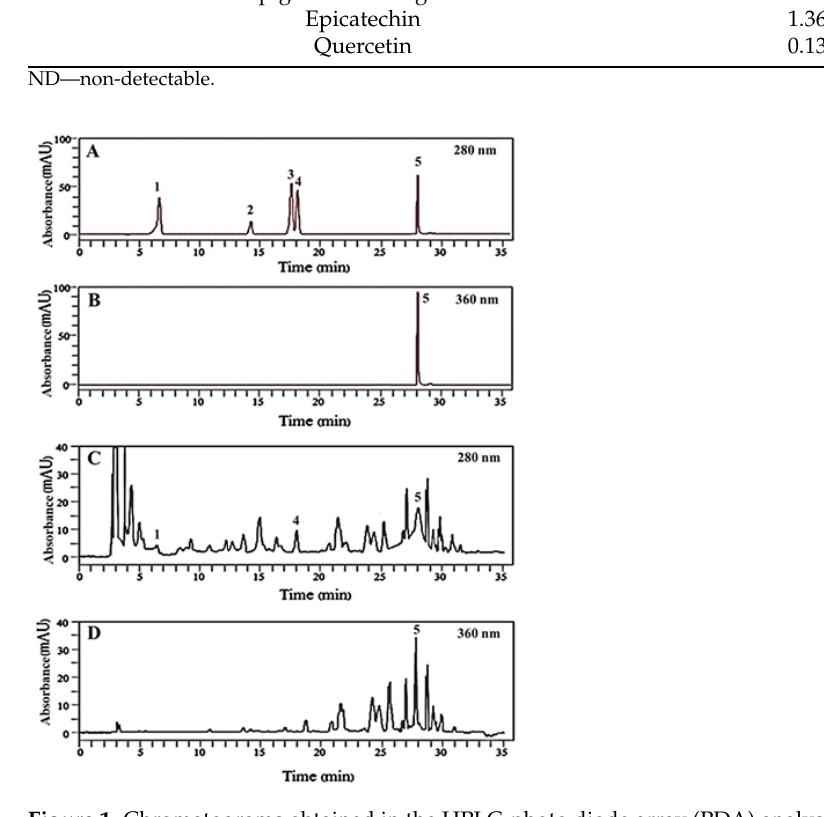
Figure 1. Chromatograms obtained in the HPLC-photo diode array (PDA) analysis of Diels aqueous extract (TTE). HPLC chromatograms of standard solutions at ( A ) 280 nm, ( B ) 360 nm, ( C ) TTE sample at 280 nm and ( D ) TTE sample at 360 nm using the solvent gradient program, as shown in Supplementary Table S2. Peaks: 1, gallic acid. (6.45 min); 2, catechin (14.52 min); 3, ( – )-epigallocatechin gallate (17.63 min); 4, epicatechin (18.35 min); 5, quercetin (28.15 min). Table 1. The composition of phenolic and flavonoid compounds in TTE analyzed by HPLC-PDA. Active Compounds in TTE (Dry Weight) × (mg/g Extract)